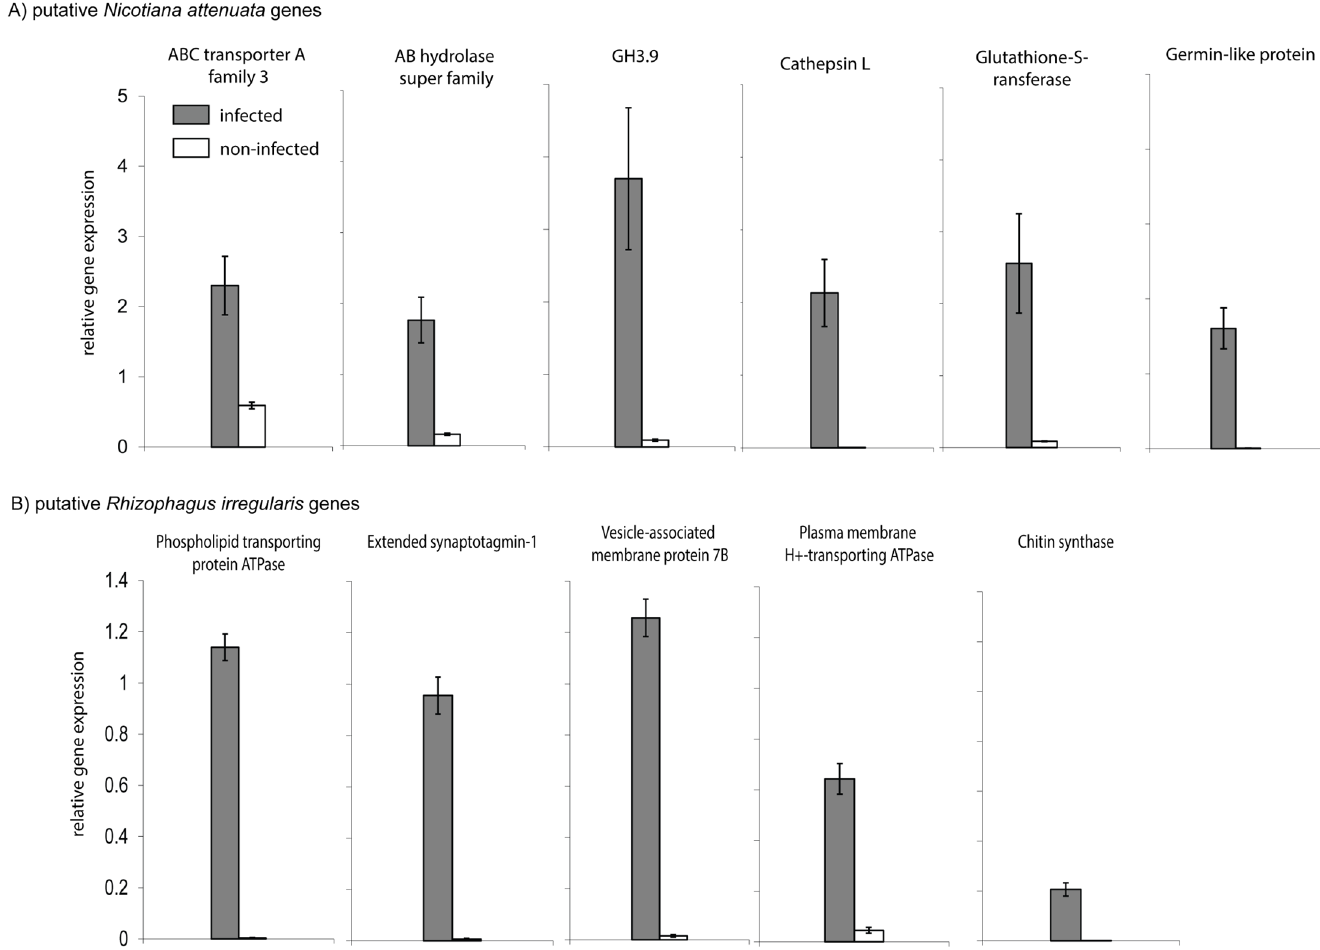
Fig 3. Validation of significantly up-regulated SuperSAGE Tags annotated to N . attenuata (A) and R . irregularis (B) by qPCR. Relative transcript levels of selected plant (A) and fungal (B) Tags significantly up-regulated ( P < 0.05) after the infection of Nicotiana attenuata by Rhizophagus irregularis . qPCR analysis was carried out on root samples harvested 35 days after inoculation. Elongation factor-1 alpha was used as a reference gene for normalization. Transcript levels were analyzed in four biological replicates ((+ se, N = 4).